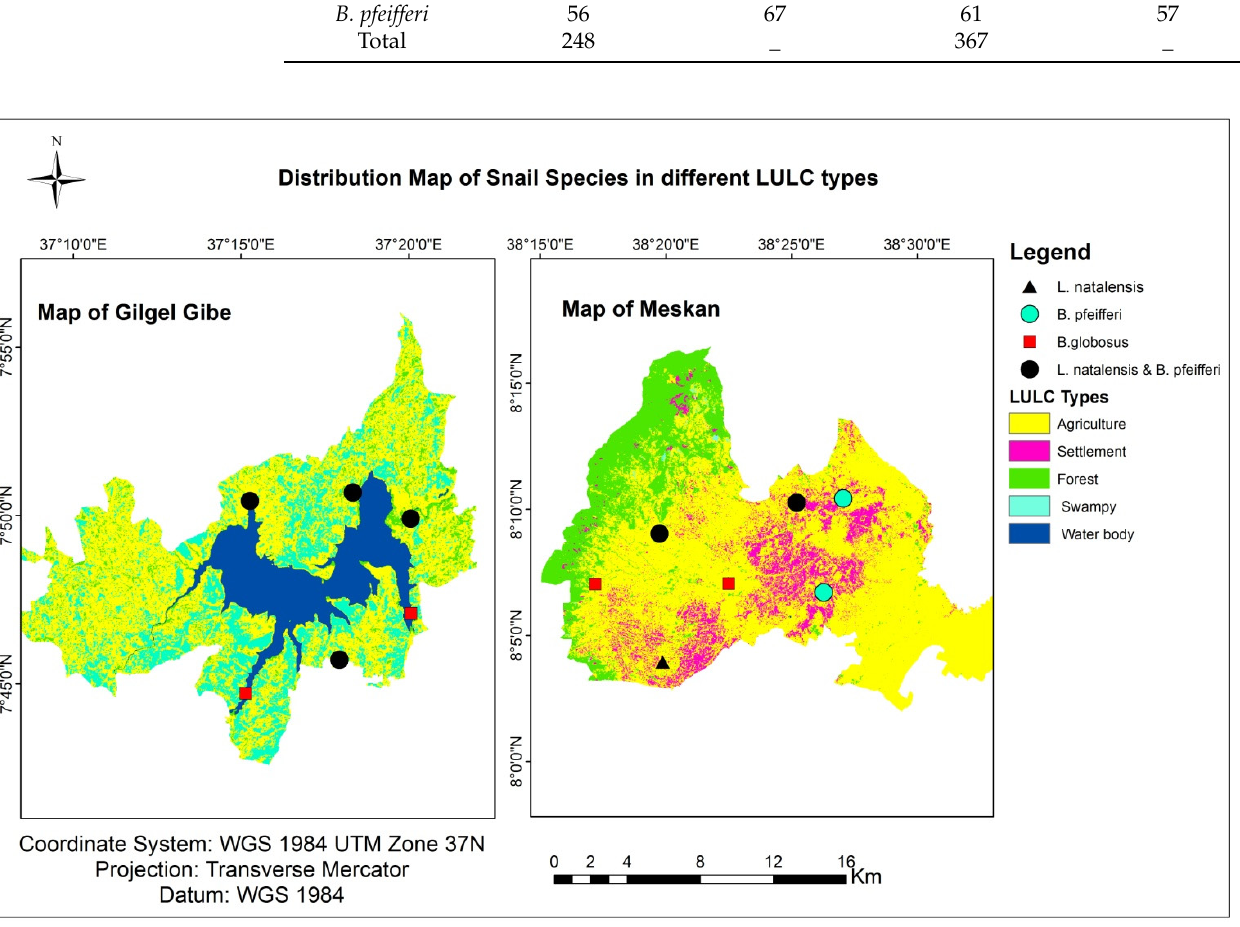
Figure 2. Distribution of snail species in relation to land use. Table 2. Land ‐ use land ‐ cover (LULC) class area coverage of the Gilgel Gibe and Meskan districts. Gilgel Gibe LULC Type